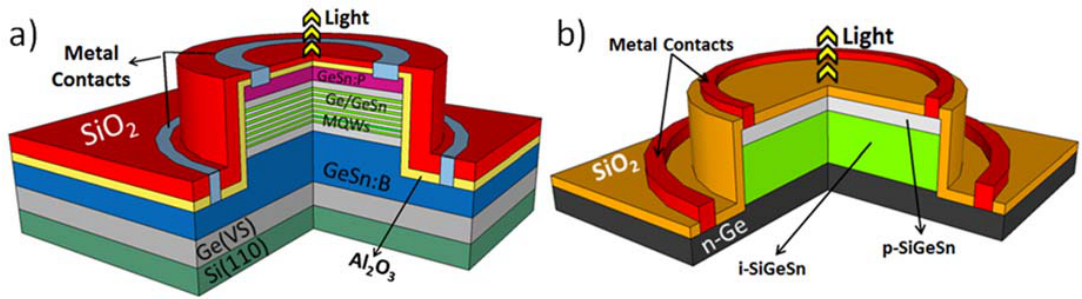
Figure 3. GeSn ‐ based LED devices. ( a ) Profile of a LED based on Ge barriers and GeSn quantum well (QW) active layers. Adapted with permission from [117]. Copyright The Optical Society, 2016. ( b ) Schematic representation of GeSiSn device. Adapted with permission from [119], Copyright AIP Publishing, 2015. Drawings not to scale.